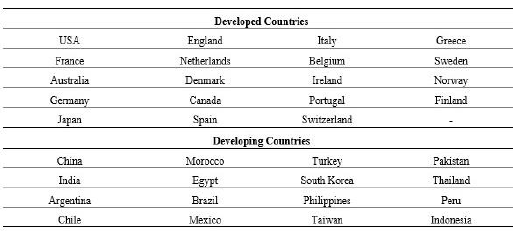
Table 2: Countries Included in the